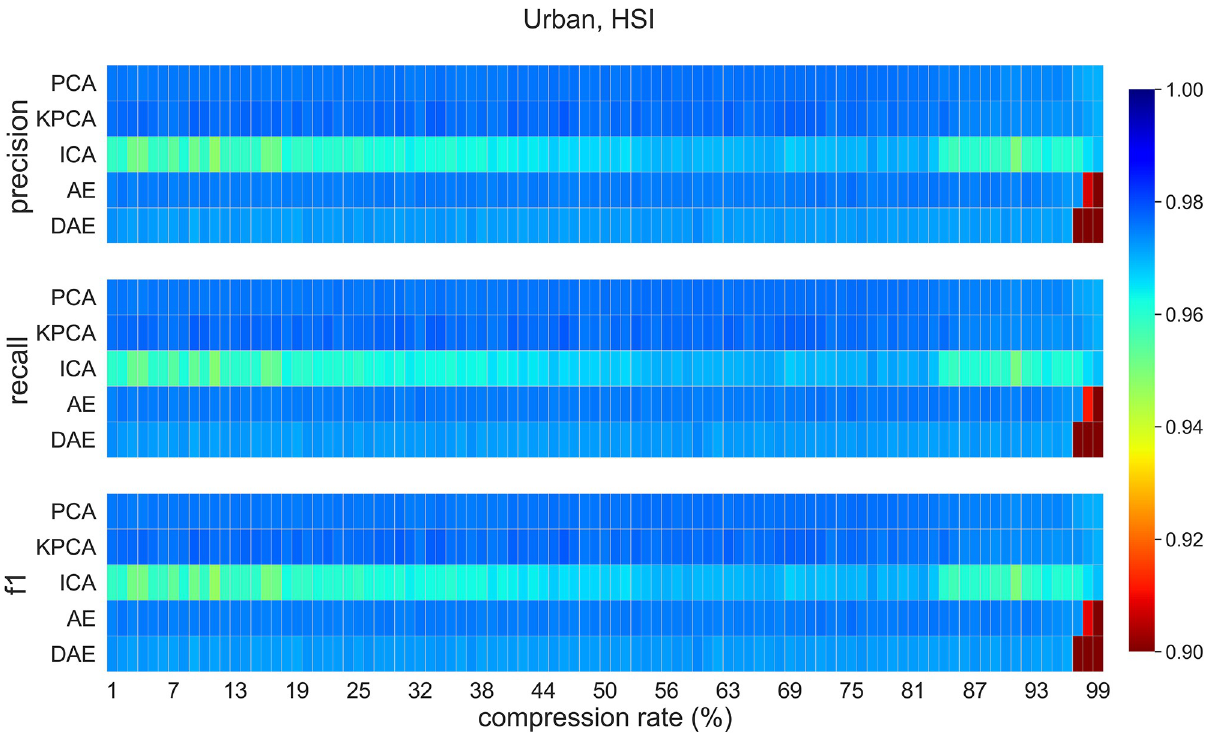
Fig 10. Urban dataset classification scores for all methods for compression rates between 1% to 99%.